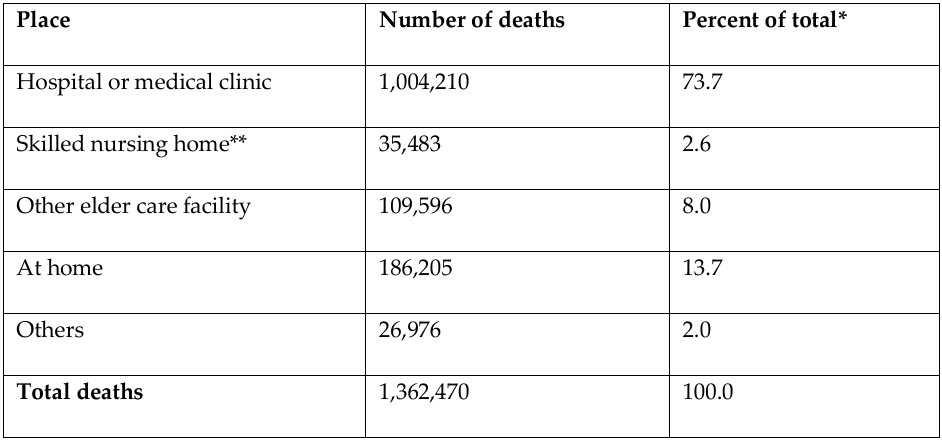
Table 1 Place of Death in Japan, 2018 (e-Stat